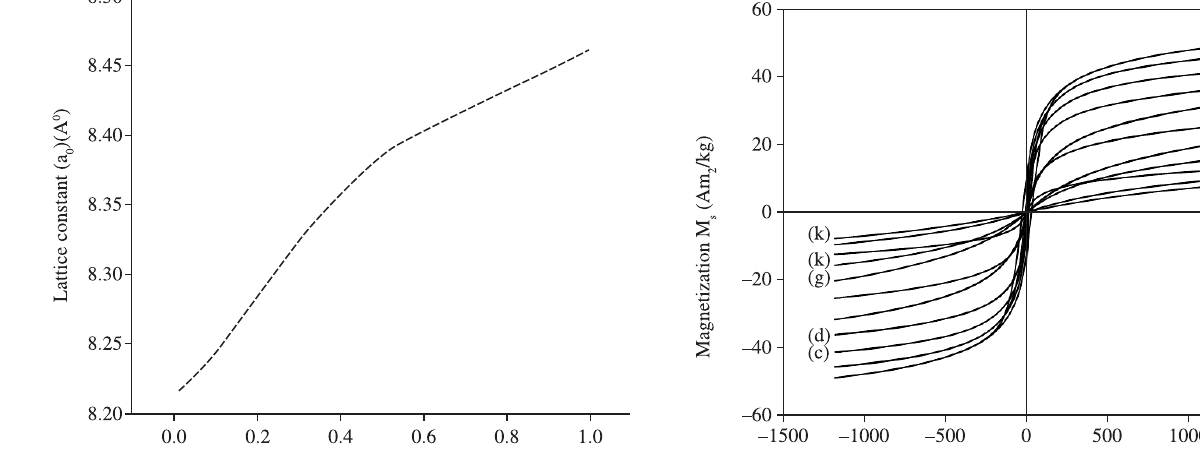
Fe O , (b) 1.0 2 4 Zn Fe O , 0.60 0.40 2 4